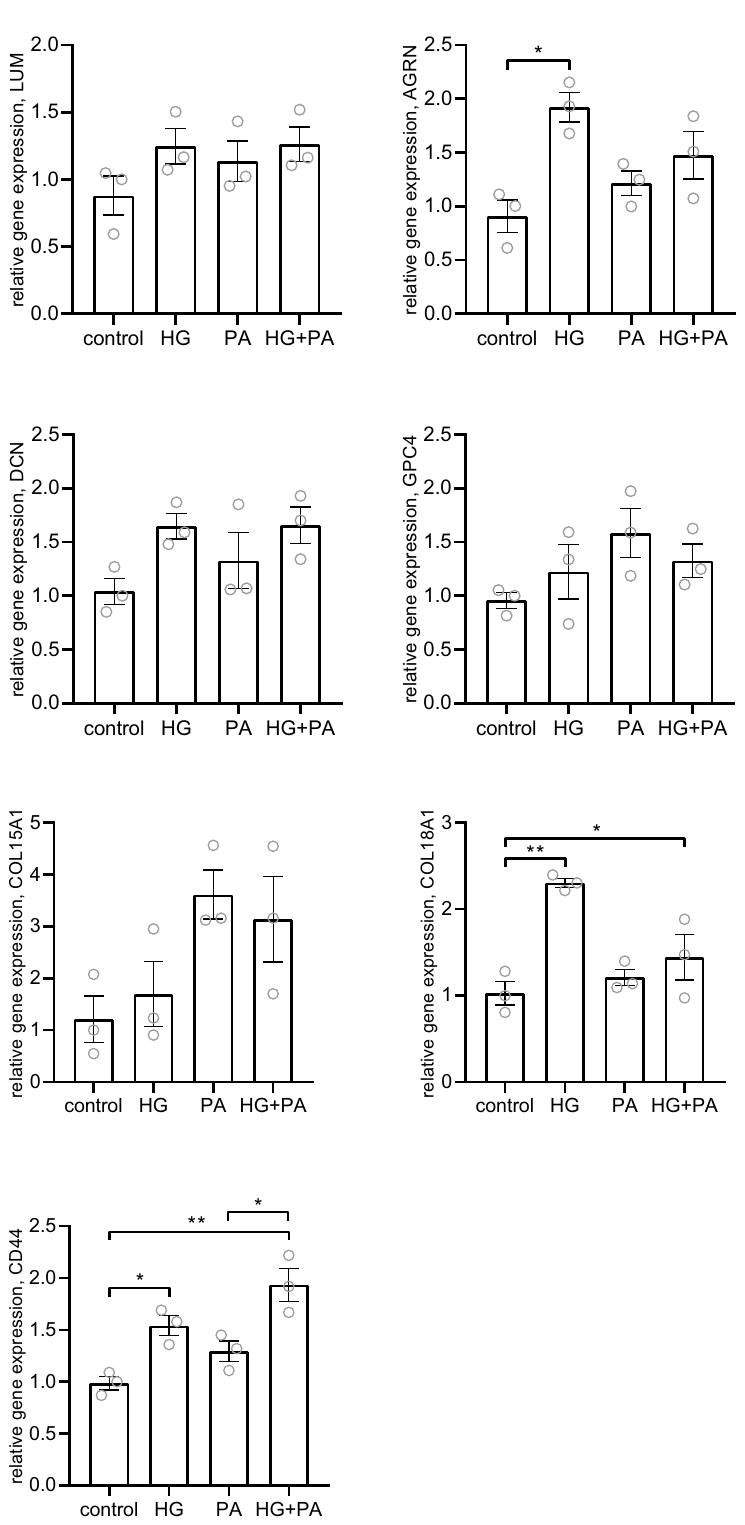
Figure 5. Gene expression of proteoglycans in human glomerular endothelial cells in vitro. Relative gene expression of the proteoglycans; LUM, AGRN, DCN, GPC4, COL15A1, COL18A1 and CD44 after treatment of human glomerular endothelial cells with high glucose (HG), palmitate (100 µM) bound to HSA (PA) or a combination of both (HG+PA) for 24 h. *P < 0.05, **P < 0.01, error bars represent